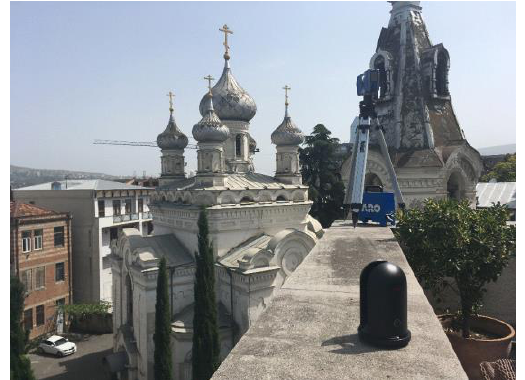
Figure 2. Russian-orthodox church in Lurdji complex;